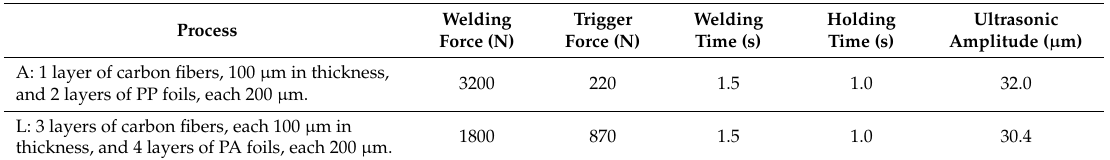
retaining force for solidification; ( e ) Demolding the ultrasonically fabricated sample from the machine. Table 1. Overview of the process conditions and the parameters for the ultrasonic fabrication of CFRP with the Branson 2000IW+ Ultrasonic Welder. Process